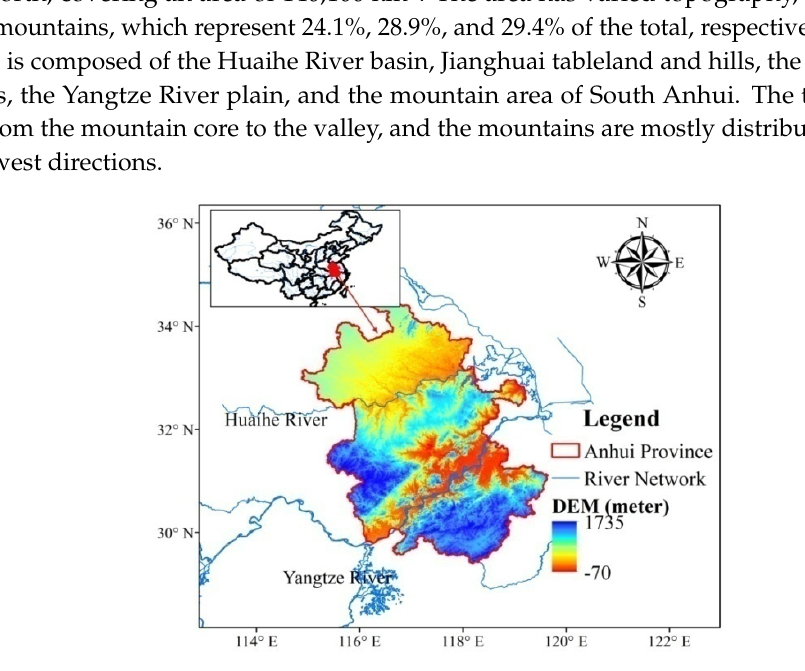
Figure 3. Connection numbers and corresponding s f (u t ) values for evaluating regional water resources carrying capacity (RWRCC) from 2005 to 2015 in Anhui Province.